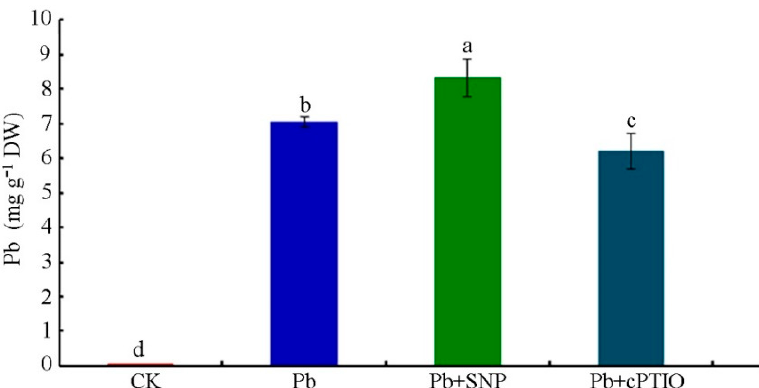
Figure 7. Influence of SNP and cPTIO on Pb uptake by tobacco BY-2 cells. Four-day-old tobacco BY-2 cells treated with 250 μ M Pb(NO 3 ) 2 alone, with 0.5 μ M SNP, or with 100 μ M cPTIO, respectively, were harvested 24 h later for determination of Pb. Cells that received the same volume of distilled water were used as a control. Data are means ± SD of three replicates. Different lowercase letters show significant differences ( p < 0.05) between the means. CK, Control.